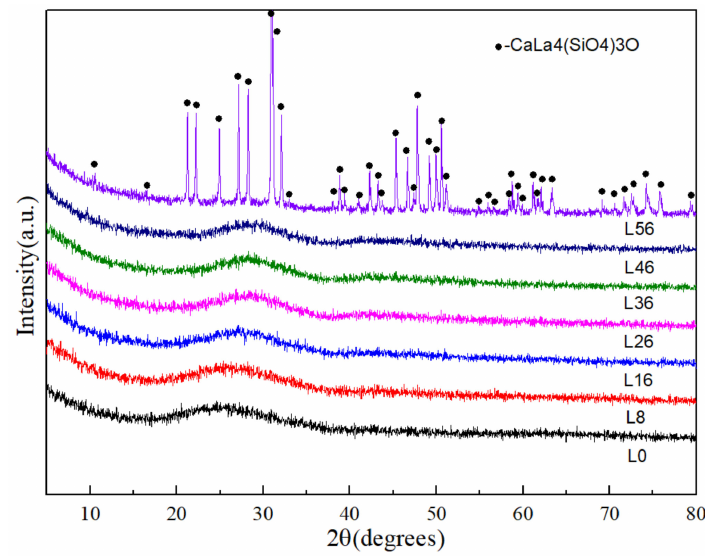
Figure 1. XRD patterns from L0 to